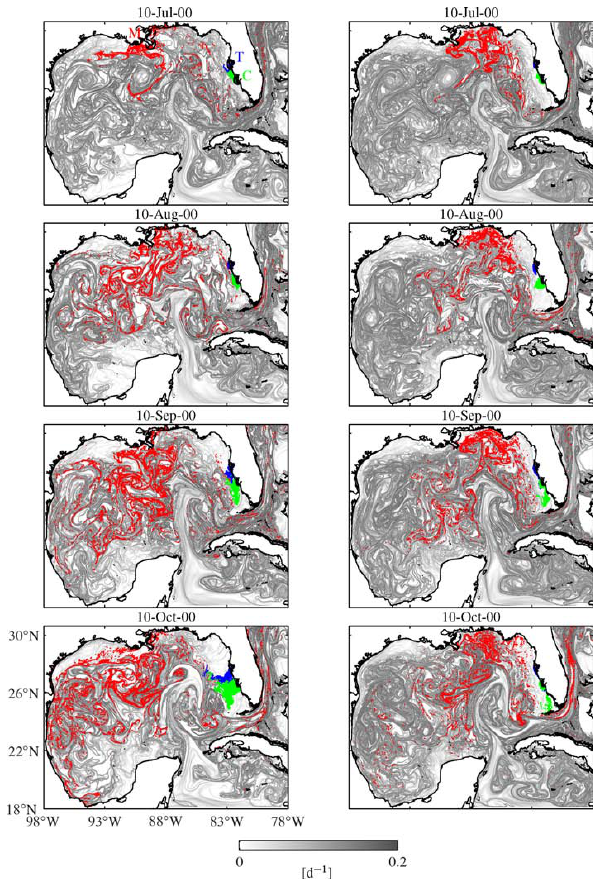
Fig. 5. As in Fig. 3, but using a gray scale and with dots overlaid indicating positions taken by passive particles deployed every other day in regions labeled M (red), T (blue), and C (green).